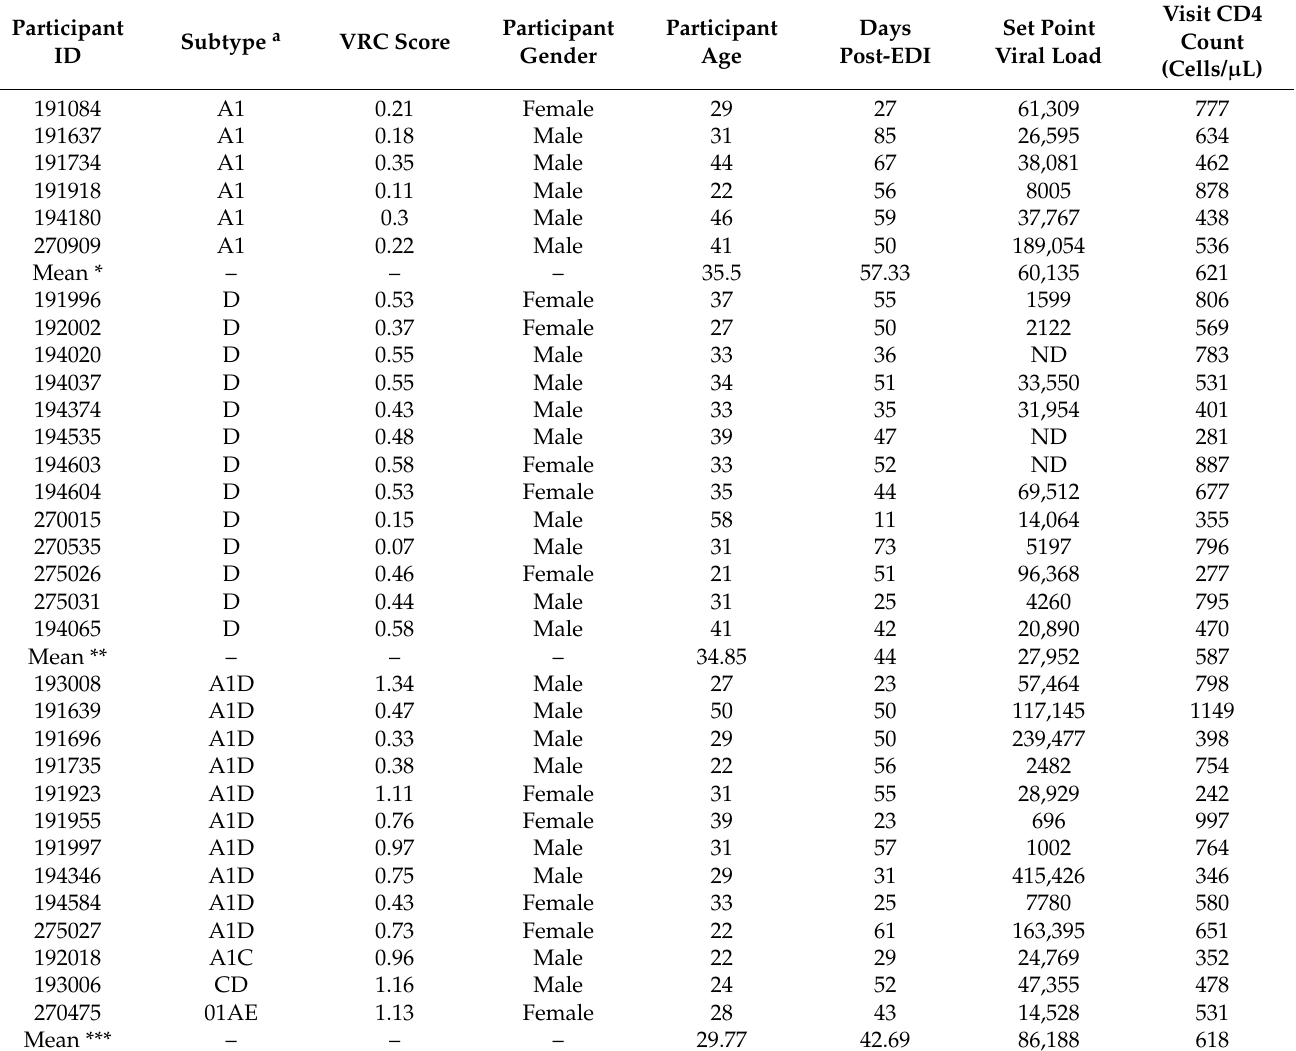
Table 1. Participants’ characteristics of 32 early infected